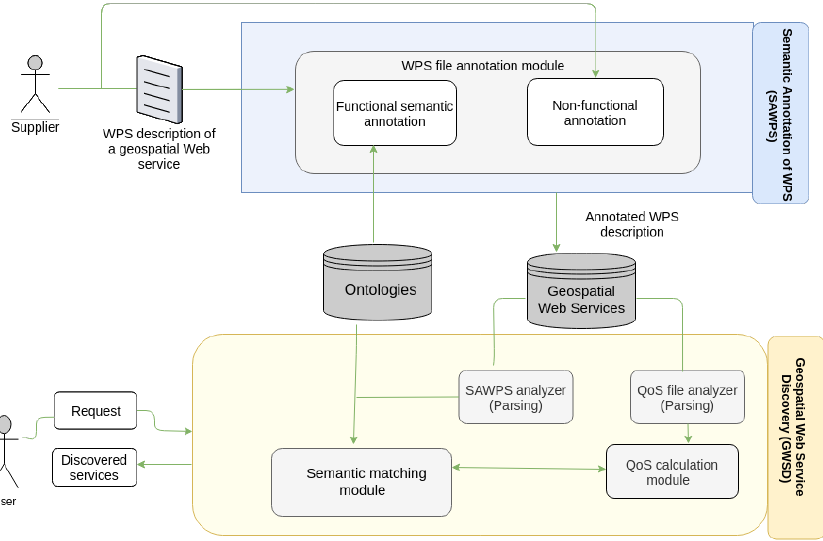
Figure 4. SAWPS and GWSD